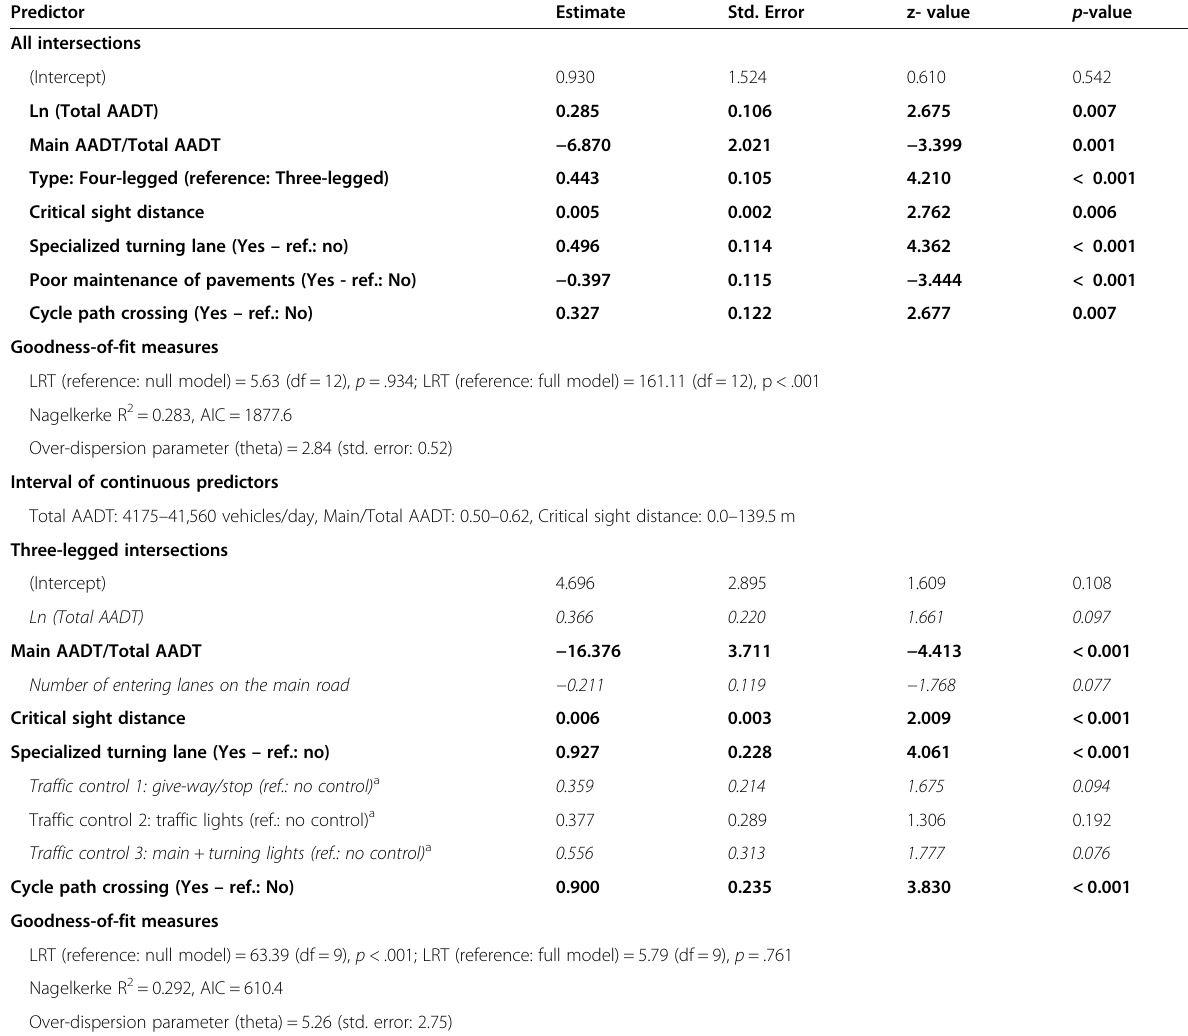
Table 3 Selected models for